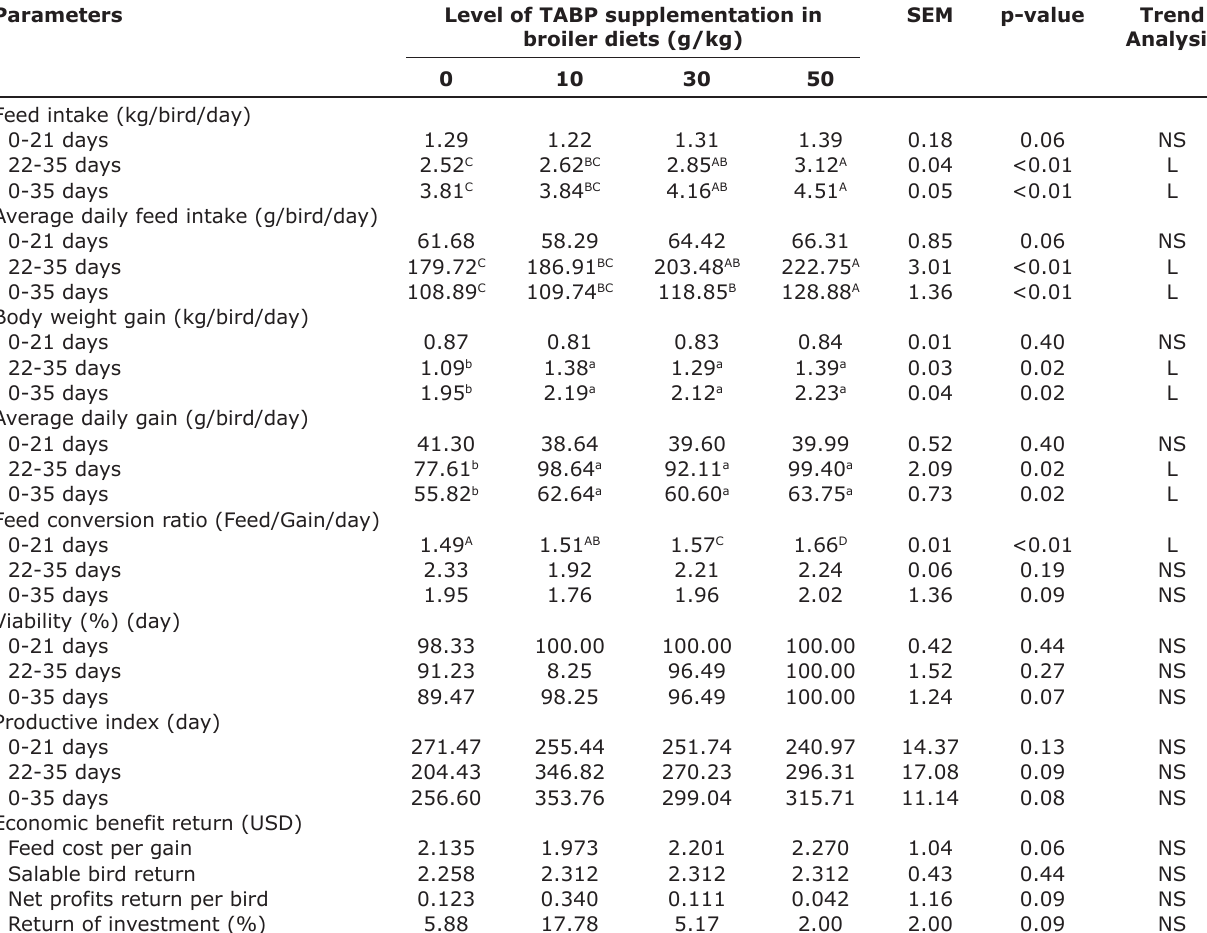
Table-2: Effects of TABP supplementation in broiler diets on productive performance and economic benefit return. Parameters